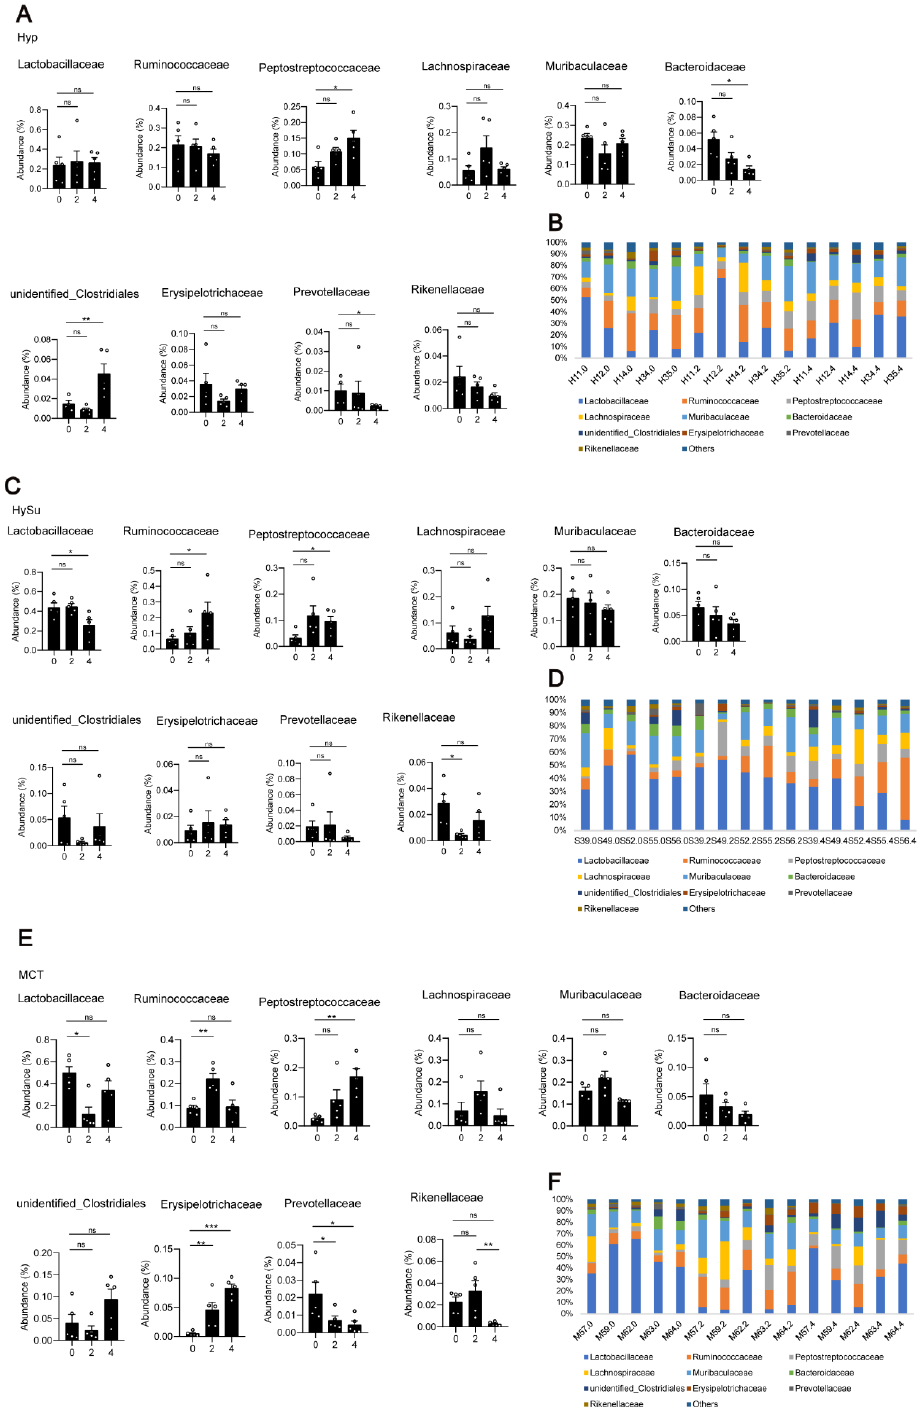
Figure 4. Fecal microbial composition at the family level. The most abundant taxa change at the family level in Hyp- ( A , B ), HySu- ( C , D ), and MCT- ( E , F ) induced PH rats. Data are presented as the mean ± SEM, n = 4–5 per group; * p < 0.05, ** p < 0.01, *** p < 0.001, ns: no significance, and one-way ANOVA followed by Student–Newman–Keuls multiple comparison test for parametric distributions. The Kruskal–Wallis test followed by the Dunnett post hoc test were used for non- parametric distributions. H11, H12, H14, H34, and H35 represent the codes of rats in the Hyp-induced group (Hyp). S39, S49, S52, S55, and S56 represent the codes of rats in the HySu-induced group (HySu). M57, M59, M62, M63, and M64 represent the codes of rats in the MCT-induced group (MCT). 0, 2, and 4 represent the week of